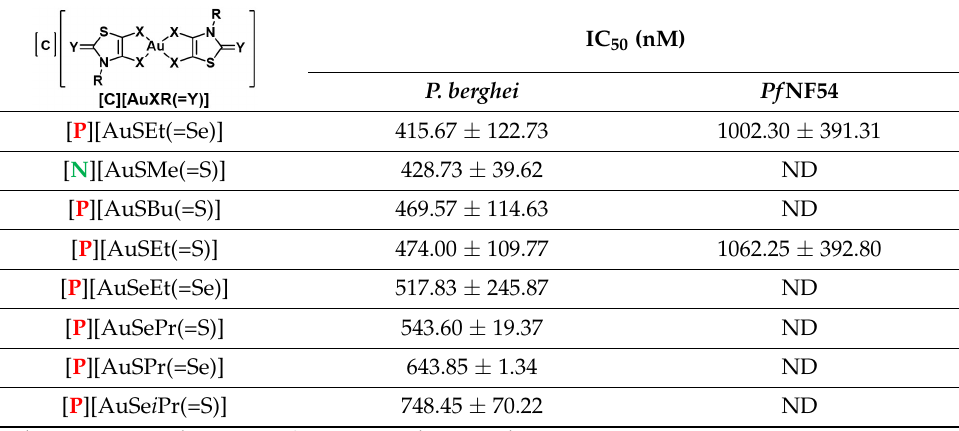
Results are represented as mean ± SD. ND—not